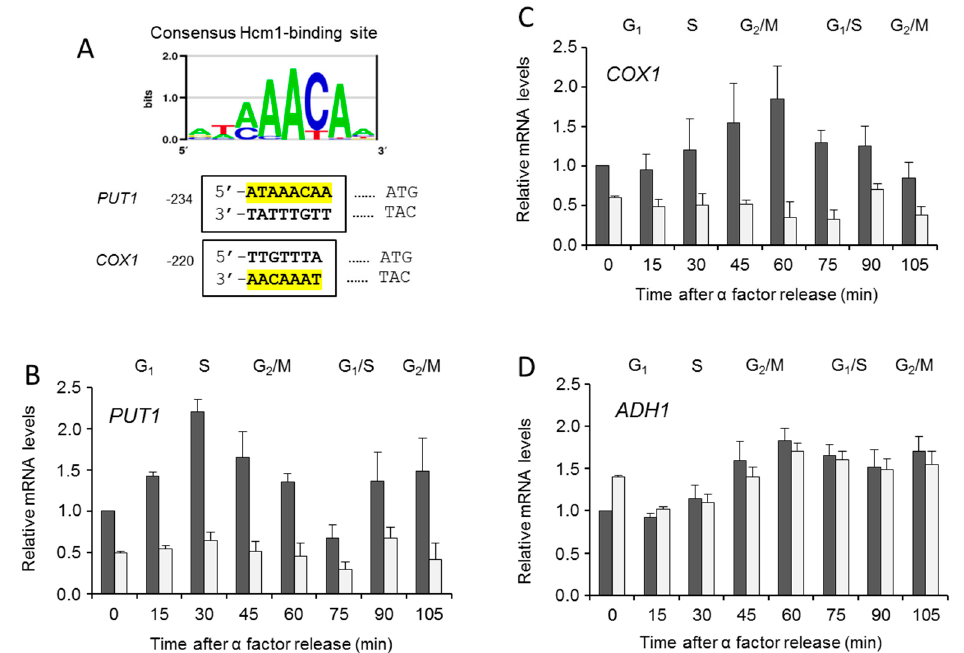
Figure 5. Hcm1-dependent gene expression and cell cycle. ( A ) Consensus binding motifs for Hcm1 in the promoter regions of PUT1 and COX1 . COX1 motif was found on the Crick strand (http://yetfasco.ccbr.utoronto.ca) [26]. WT and Δ hcm1 cells grown exponentially were synchronized to G1 with α -factor for 2 h, and mRNA of genes were determined by quantitative real-time PCR analysis at different times after release. ( B ) mRNA expression of PUT1 , a nuclear encoded gene. ( C ) mRNA expression of COX1 , a mitochondrial encoded gene. ( D ) mRNA expression of ADH1 , a nuclear encoded gene used as a control. The data are represented as the means ± SD from at least three independent experiments.